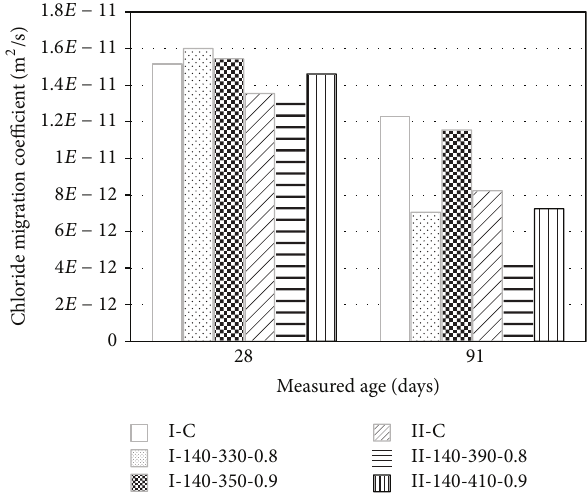
Figure 9: Chloride migration coefficient of concrete measured at 28 and 91